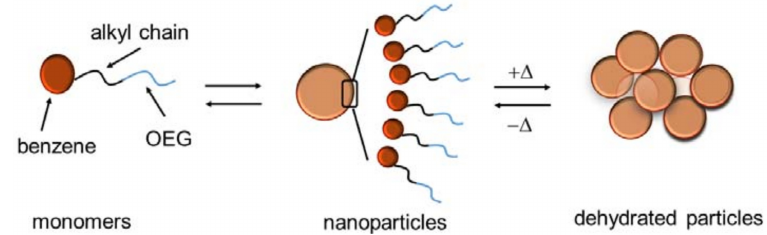
Figure 5. Predicted mechanism of the self-assembly of UBD in aqueous